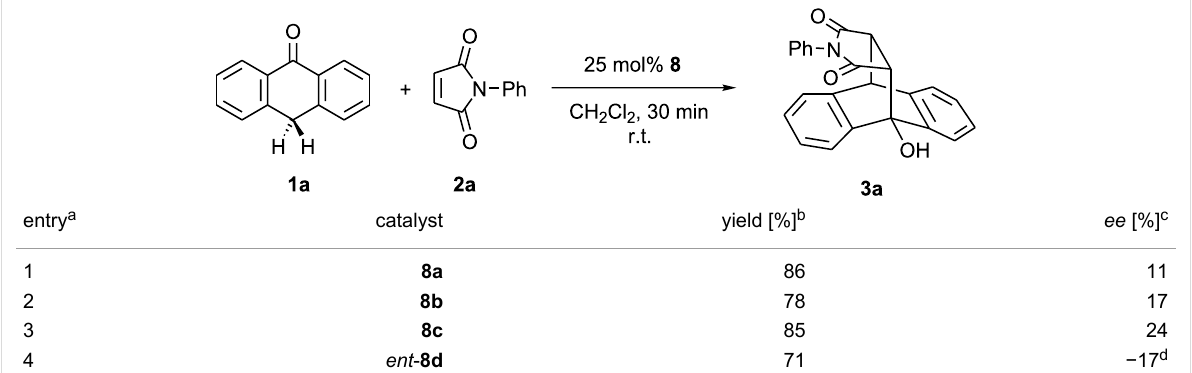
Table 1: First evaluation step of chiral bisamidine catalysts.